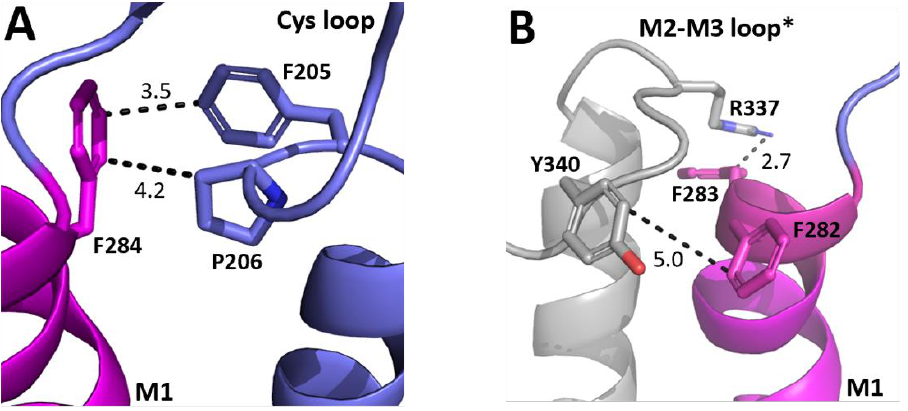
Figure 4. Possible M1 helix residue interactions with the ECD. ( A ) The interface between the top of the M1 helix (magenta) and the ECD Cys-loop (blue). ( B ) The interface between the top of the M1 helix (magenta) and the M2 – M3 loop of the neighbouring subunit (grey). Distances are in Å . * indi- M1 helix (magenta) and the M2–M3 loop of the neighbouring subunit (grey). Distances are in Å. cates a neighbouring subunit. * indicates a neighbouring